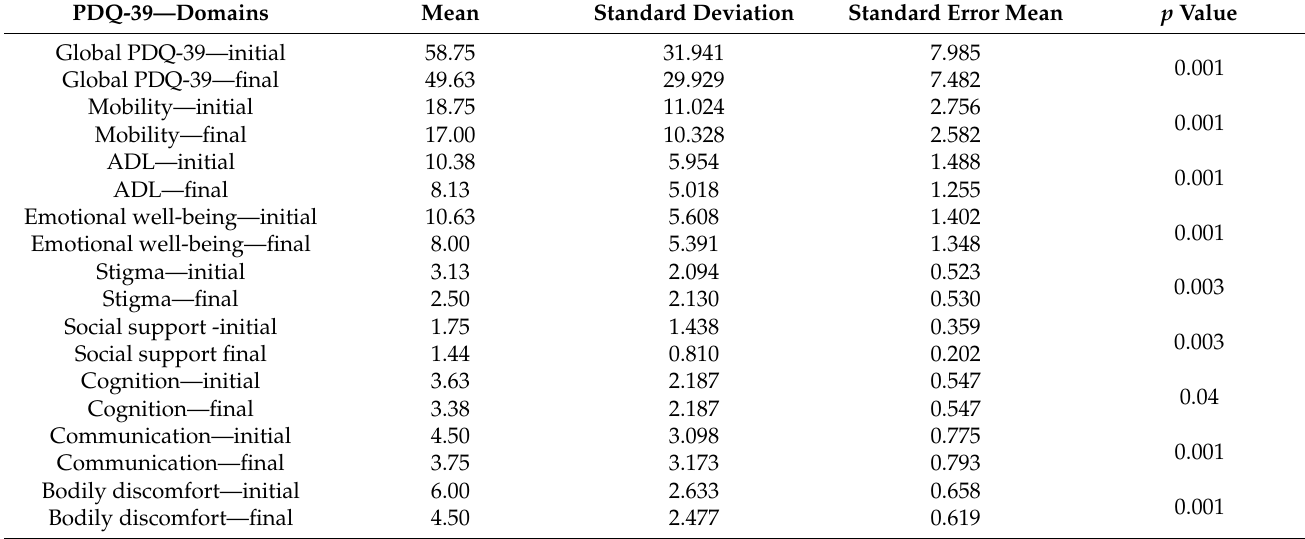
Table 3. Comparison of initial and final PDQ-39 scale values in the study